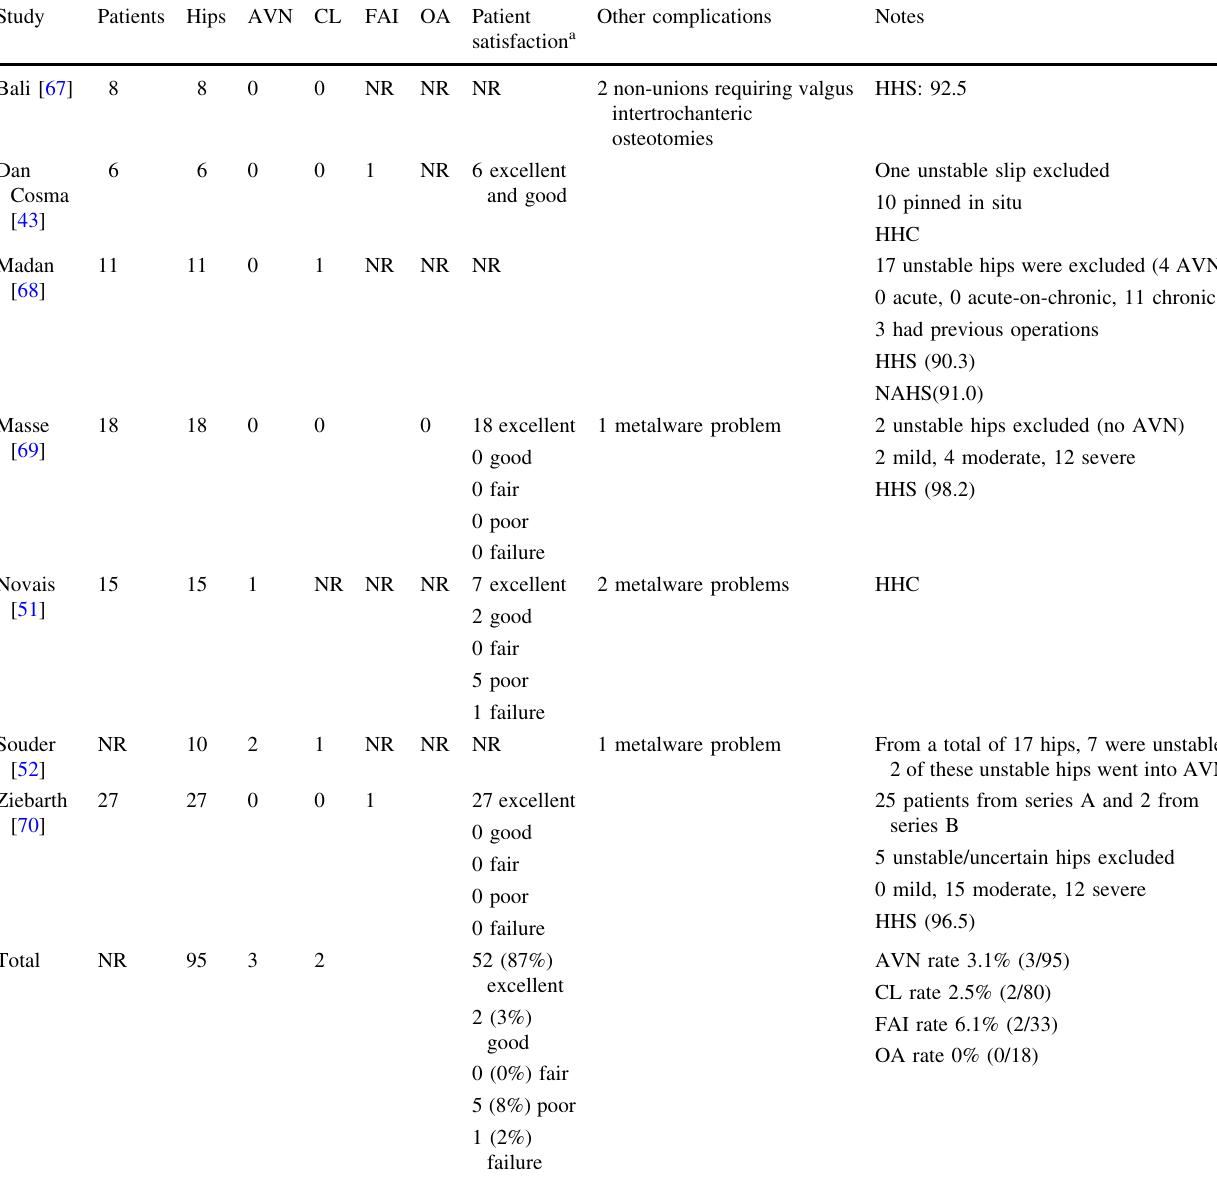
Table 9 Studies of Ganz surgical dislocation in stable slips